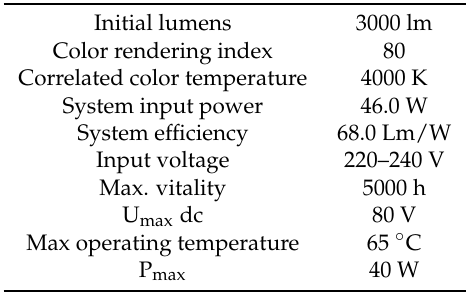
Table 1. Parameters of light of Fortimo LED DLM 3000 44 W/840 Gen3.